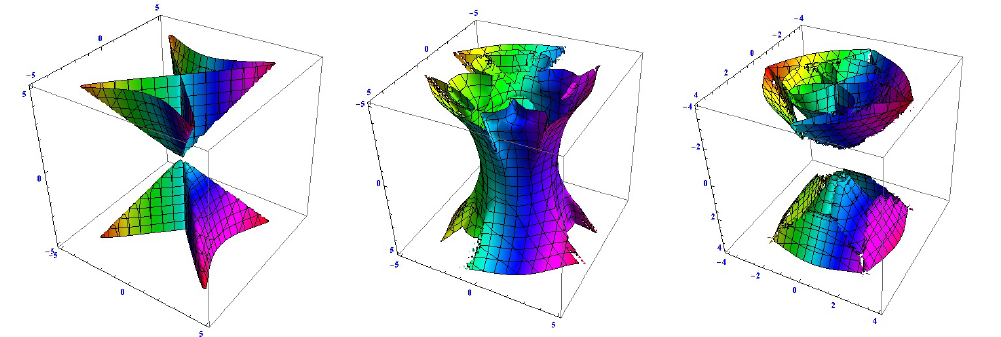
Figure 6. Enneper’s algebraic maximal surfaces in inhomogeneous tangential coordinates ( Left ): ˆ Q 1 ( a , b , c ) = 0, ( Middle ): ˆ Q 2 ( a , b , c ) = 0, ( Right ): ˆ Q 3 ( a , b , c ) =